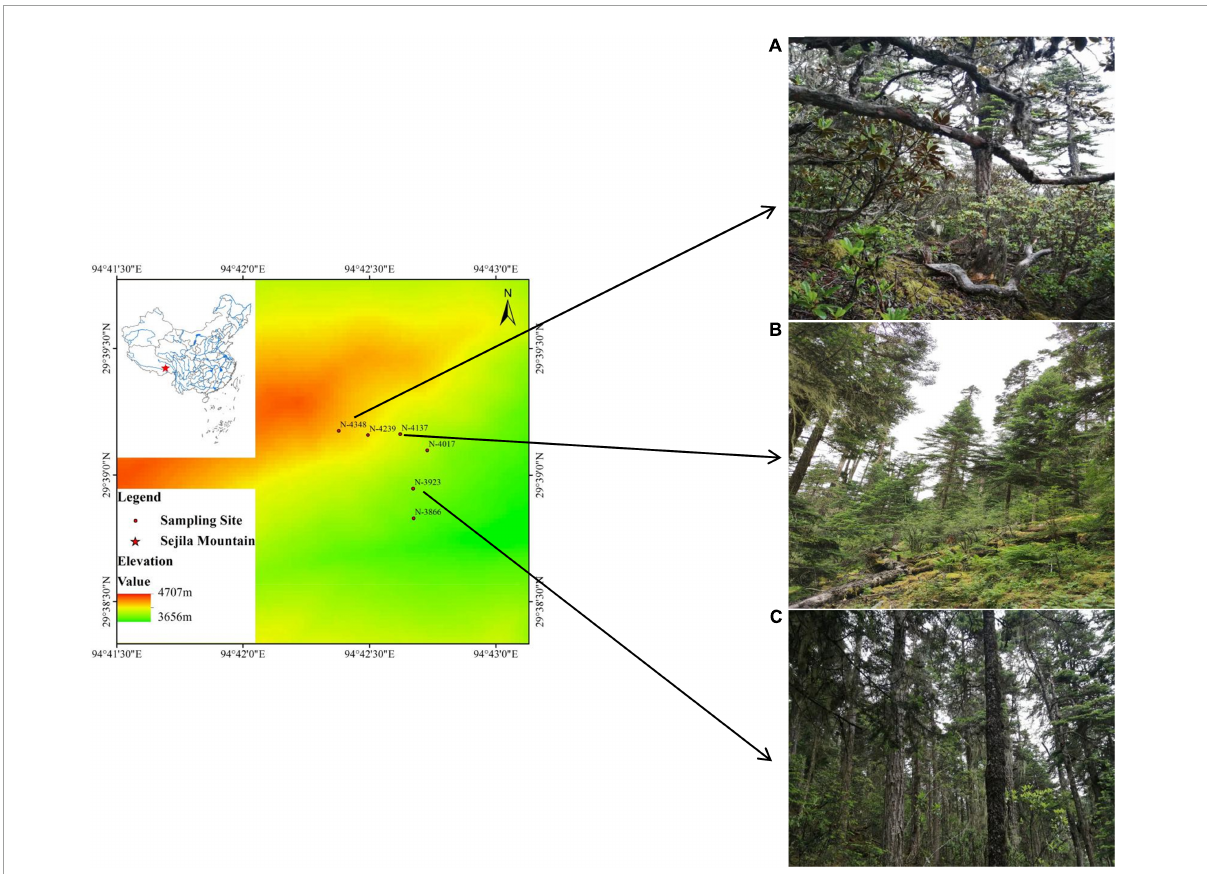
FIGURE1 Location of seedling sampling sites. Three photos of sampling plots in (A) 4,348 m, (B) 4,137 m, and (C) 3,923